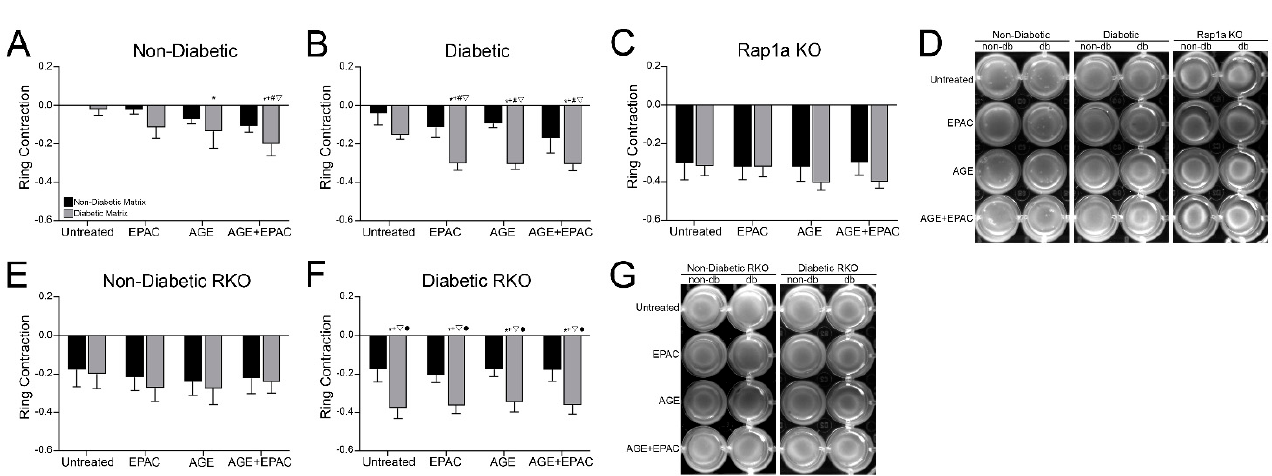
Figure 2. Cardiac fibroblast matrix contraction was altered by differing levels of AGE/RAGE signaling and diabetic matrix components. Hearts from ( A ) non-diabetic, ( B ) diabetic, ( C ) Rap1a KO, ( E ) non-diabetic RKO, and ( f ) diabetic RKO mice were used to isolate cardiac fibroblasts. Fibroblasts were embedded in non-diabetic (non-db; black bar) and diabetic (db; gray bar) collagen matrix and treated with EPAC (100 µ M), exogenous AGEs (0.5 mg/mL), or EPAC+exogenous AGEs (100 µ M and 0.5 mg/mL, respectively). After 7 days, images of matrices were captured and the area of the contractile ring was assessed. Data depicted in graphs are differences in contractile rings between treatment groups and the control group. The control group was set as untreated non-diabetic fibroblasts embedded in non-diabetic matrix. The control group was set to 0, with a positive value indicating a larger ring area (less matrix contraction), while a negative value denotes a smaller ring area (more matrix contraction) compared to control group. ( D , F , H ) Representative matrix images for each genotype and treatment. Data are mean ± SEM, n = 5–10, and statistical analysis consisted of a two-way ANOVA followed by a Fisher’s Least Significant Difference post hoc. Symbols above specific bars denote significant difference compared to a specific treatment group ( p < 0.05; * vs. untreated in non-db matrix, + vs. untreated in db matrix, # vs. EPAC in non-db matrix, vs. AGE in non-db matrix, and vs. AGE+EPAC in non-db matrix).